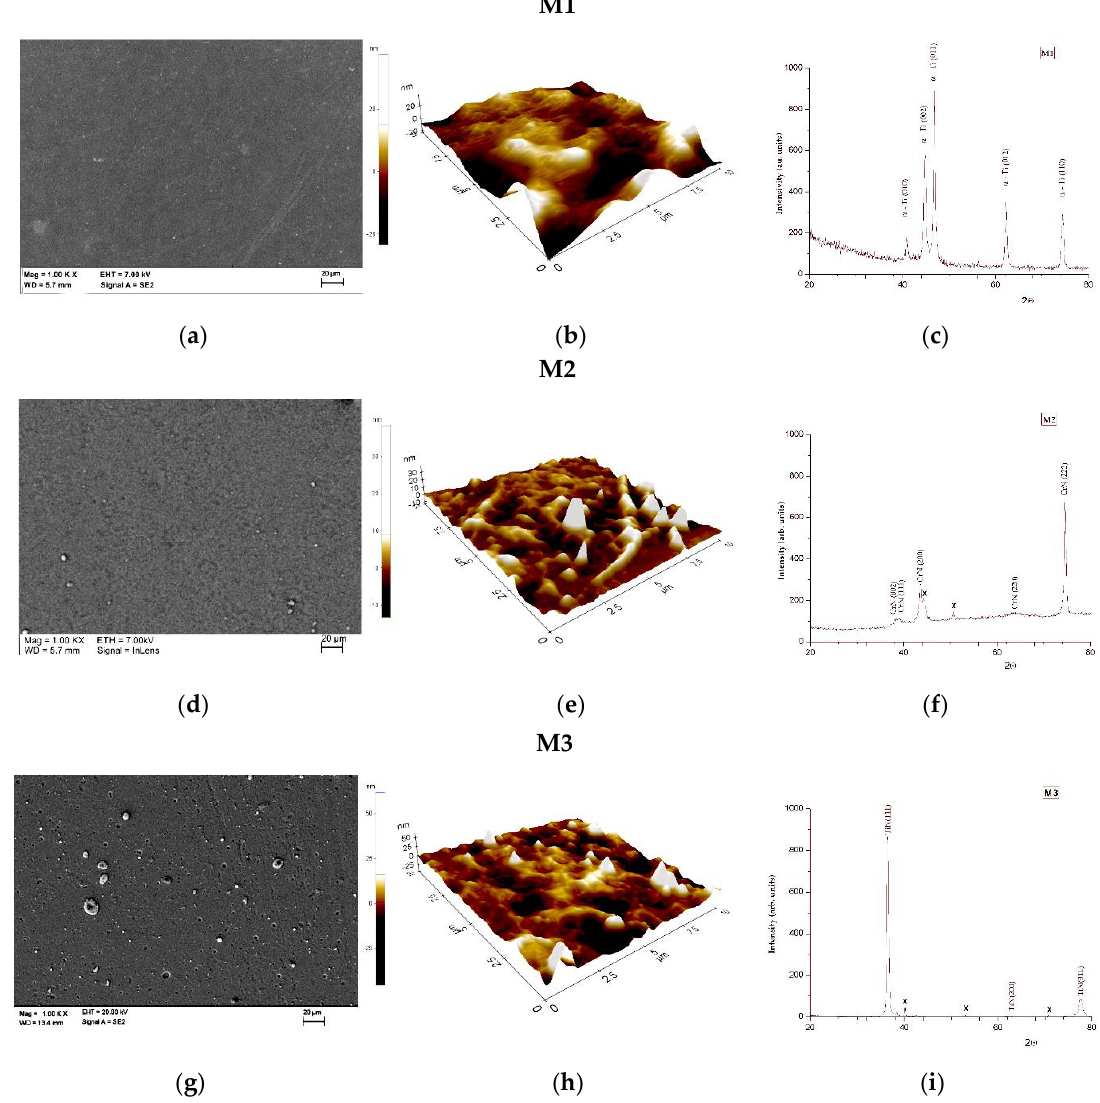
Figure 3. Images of surface topography phase composition measurements, for M1 samples group ( a) SEM image; ( b ) atomic force microscopy (AFM) results ( c ) X-ray diffraction (XRD) pattern; for M2 samples group ( d ) SEM image; ( e ) AFM results ( f ) XRD pattern and for M3 samples group ( g ) SEM image; ( h ) AFM results ( i ) XRD pattern. Table 6. Results of AFM surface roughness measurements.